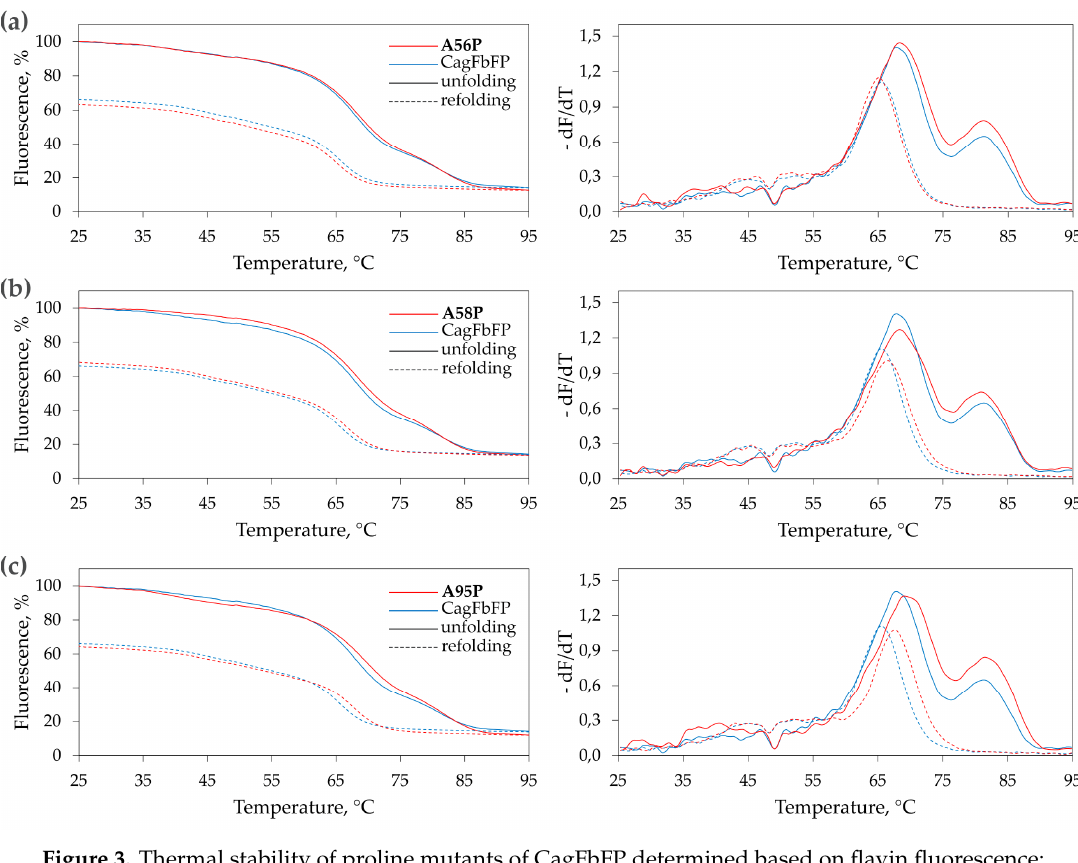
Figure 3. Thermal stability of proline mutants of CagFbFP determined based on flavin fluorescence: ( a ) CagFbFP-A56P; ( b ) CagFbFP-A58P; and ( c ) CagFbFP-A95P. The dependence of fluorescence on the temperature of the sample during heating (solid lines) and cooling (dashed lines) is shown on the left, and the derivative of the fluorescence with respect to the temperature is shown on the right. Each experiment was conducted independently four times, and the data were averaged for plotting. Characteristic unfolding and refolding temperatures are summarized in Table 1. Table 1. Melting temperatures of CagFbFP and its proline mutants. T m1 and T m2 correspond to the two melting transitions (Figure 3), and T r corresponds to the temperature of refolding. Errors are standard deviations of the values observed in four independent experiments.